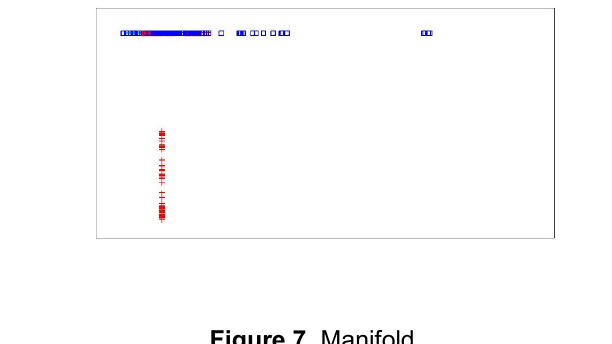
Figure 7 . Manifold